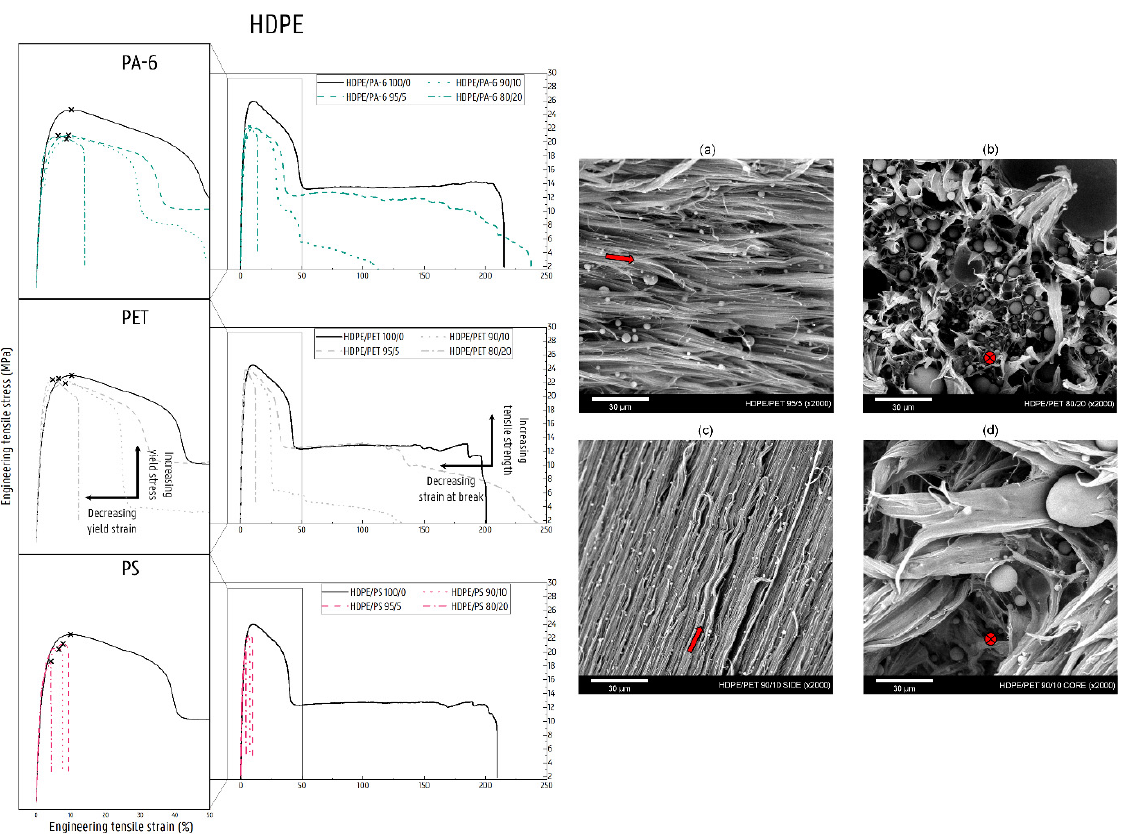
Figure 10. Stress–strain curves of the NPO-contaminated HDPE matrices (0, 5, 10, and 20 wt% PA-6, PET, or PS). The scanning electron microscopy (SEM) images show the area of rupture of the tensile-tested (deformed) binary blend specimens: ( a ) HDPE/PET 95/5, ( b ) HDPE/PET 80/20, ( c ) HDPE/PET 90/10 side region, and ( d ) HDPE/PET 90/10 core region. The red arrow indicates the polymer flow.